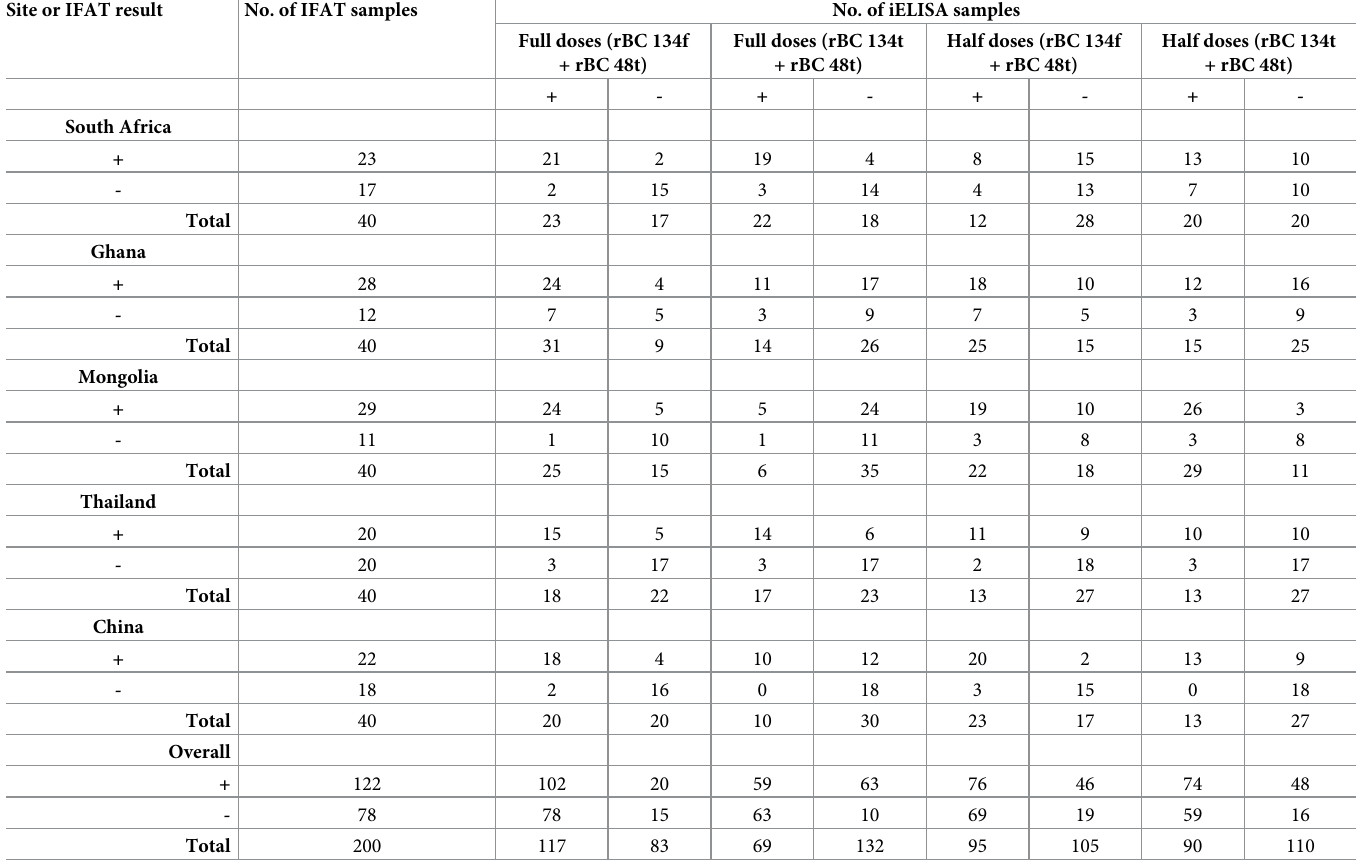
Table 3. Summary of iELISA and IFAT results with cocktail recombinant protein results using field sera collected from different locations endemic for B . caballi . Site or IFAT result No. of IFAT samples